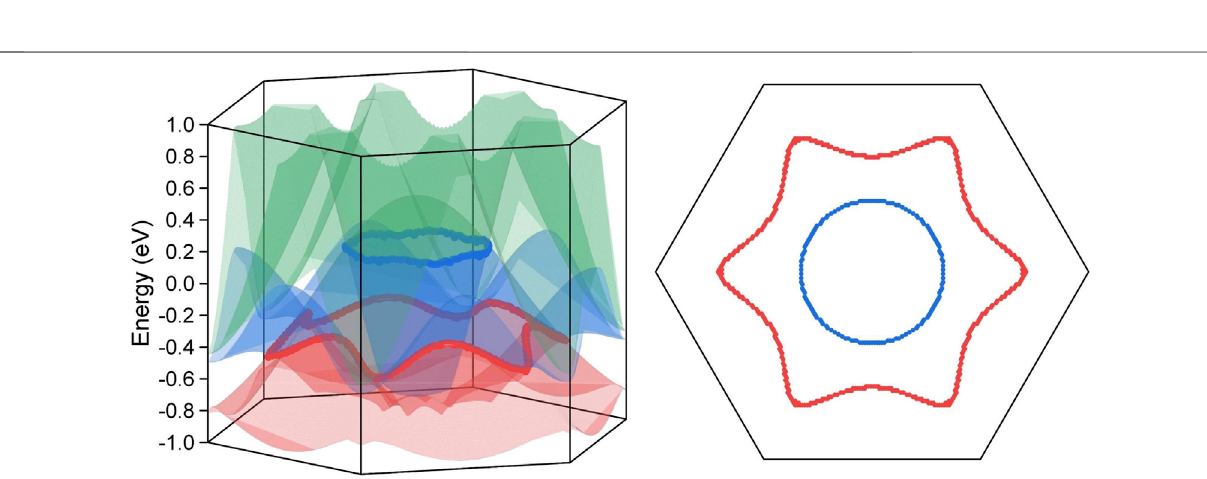
FIGURE 4 | The three dimensional surface dispersion of the three crossing bands along the k z (cid:2) 0 plane for BaAgBi without SOC effect in the left panel. The crossing lines are labelled by red and blue dots, which correspond to the two Weyl nodal rings. The exact spatial distribution of the two Wey nodal rings along the k z (cid:2) 0 plane in the right